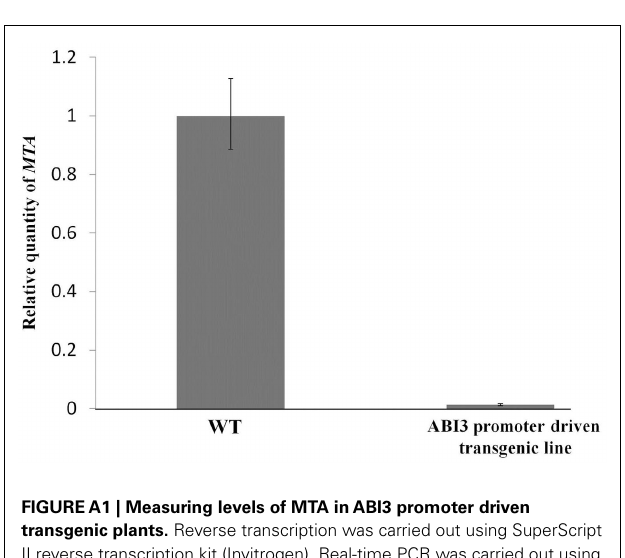
FIGUREA1 | Measuring levels of MTA inABI3 promoter driven transgenic plants. Reverse transcription was carried out using SuperScript II reverse transcription kit (Invitrogen). Real-time PCR was carried out using the MX3005P qPCR machine and the Brilliant SYBR Green qPCR master